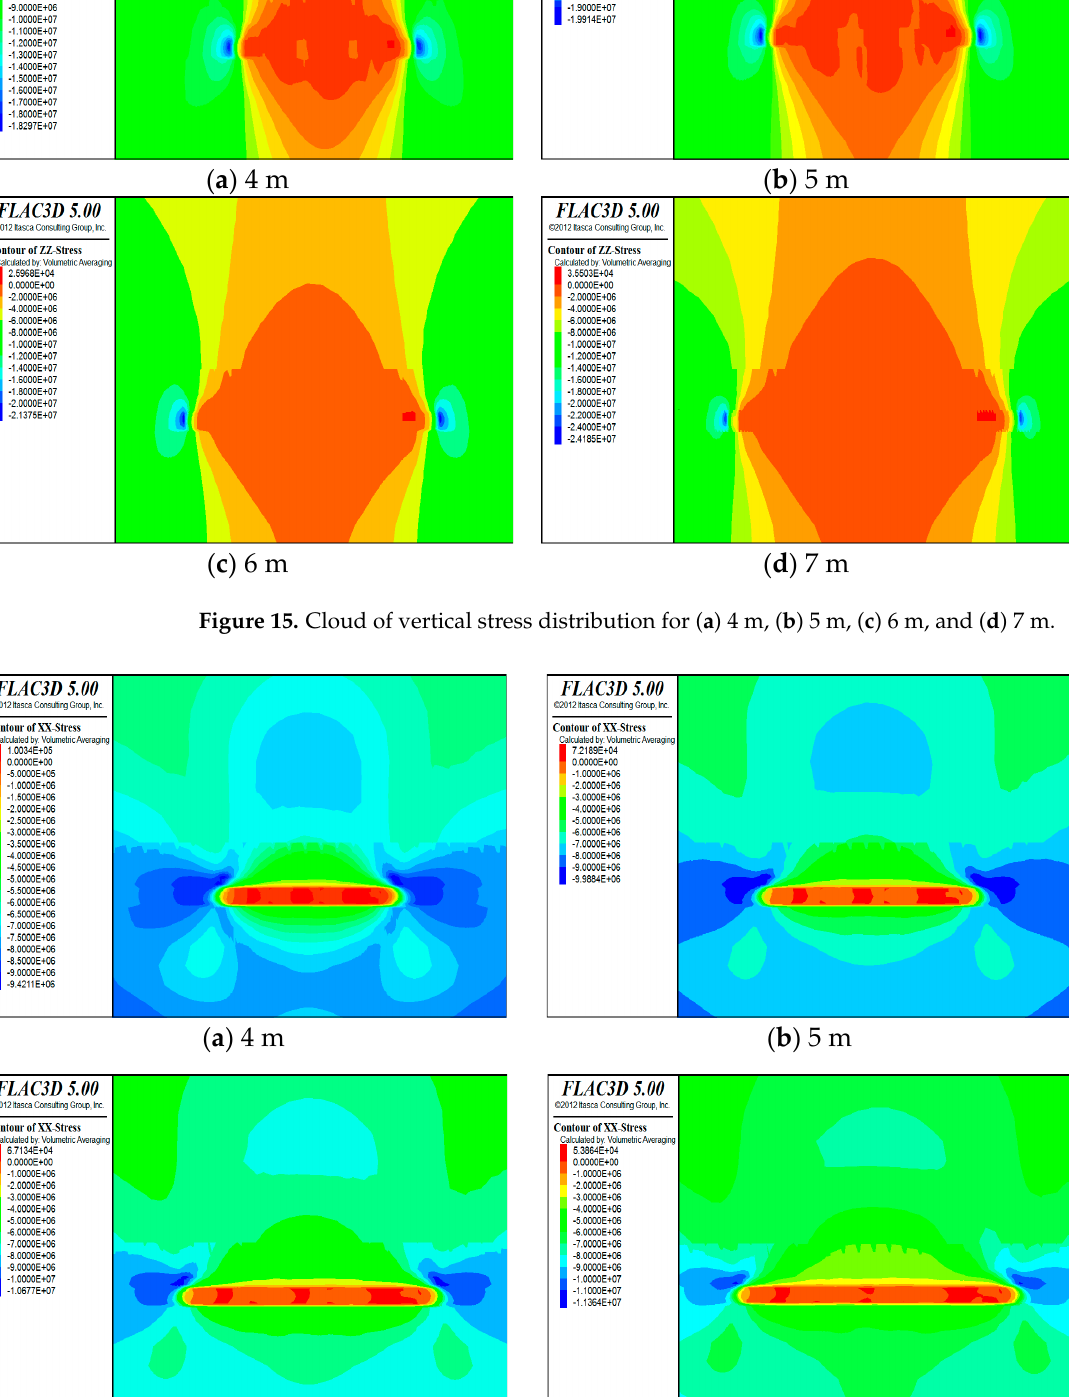
Figure 16. Horizontal stress distribution cloud for ( a ) 4 m, ( b ) 5 m, ( c ) 6 m, and ( d ) 7 m.